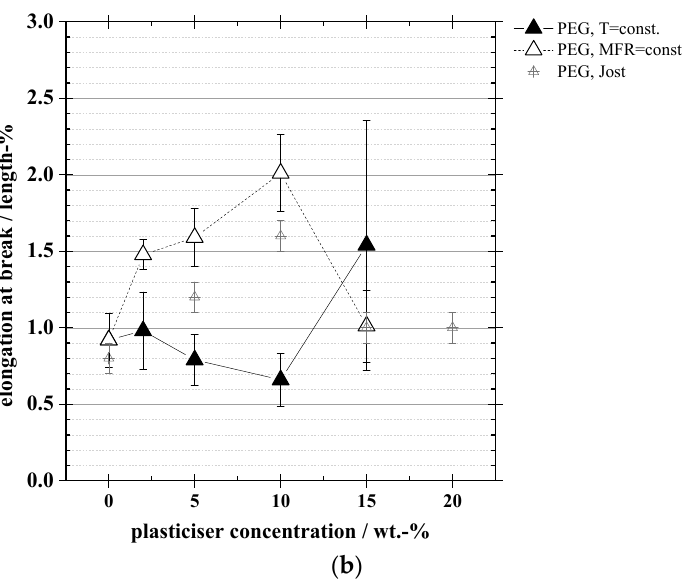
Figure 8. Elongation at break as function of plasticizer concentration: ( a ) of TEC; ( b ) of PET. Comparison with results of Jost. MFR: melt flow rate during extrusion; T: temperature during extrusion.